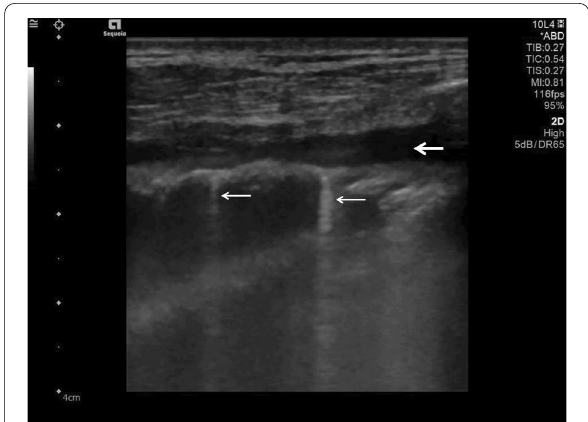
Fig. 6 Lung ultrasonography using a linear probe. B-lines (white arrows) with irregular pleura and a small pleural effusion (bold white arrow)